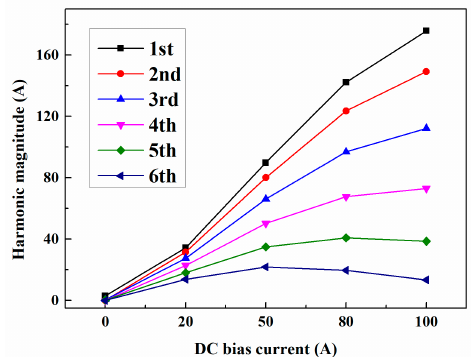
Figure 6. Harmonic magnitude of UHV transformer under DC bias current.